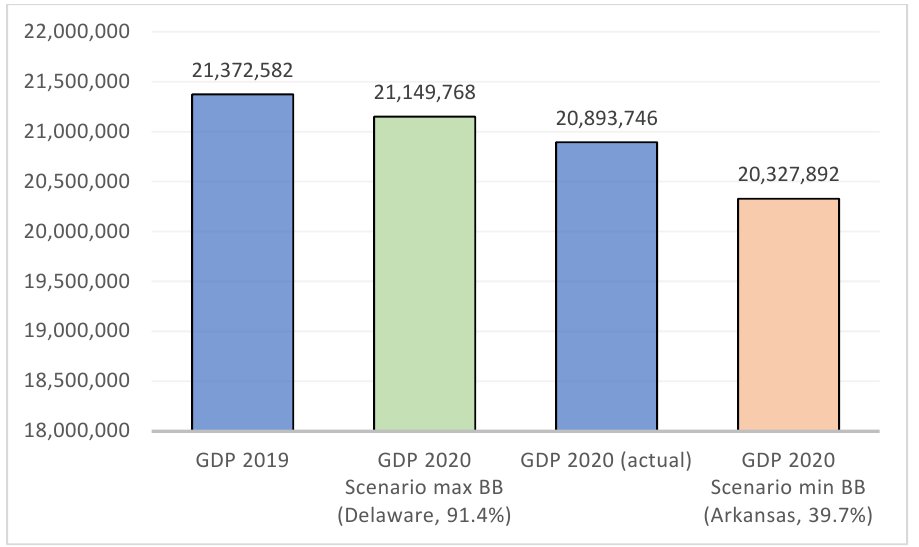
Figure 3. National evolution of GDP by broadband scenario.